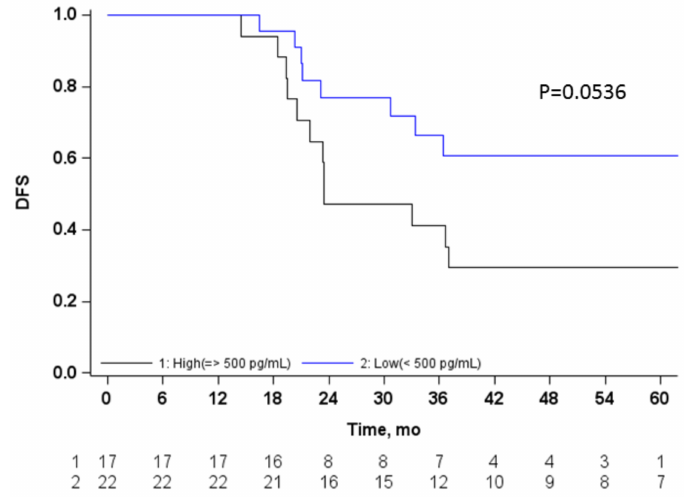
Figure 4. Disease-free survival (DFS) in 39 patients undergoing surgery for giant cell tumor of bone according to s-CTX at